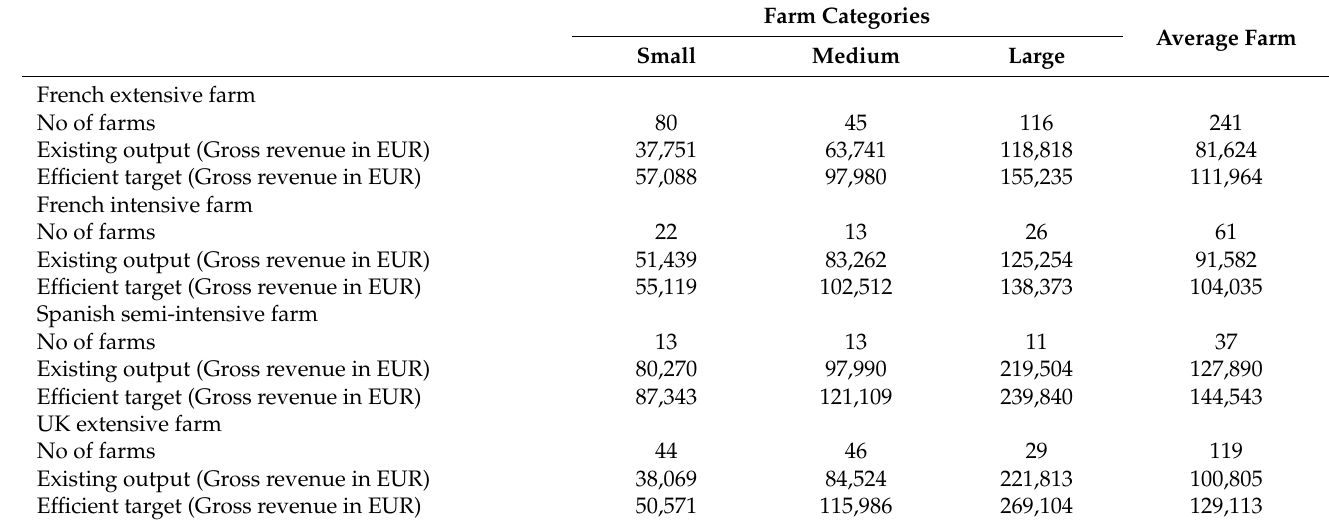
Table 2. Average existing and efficient frontier output for sheep farms by farm